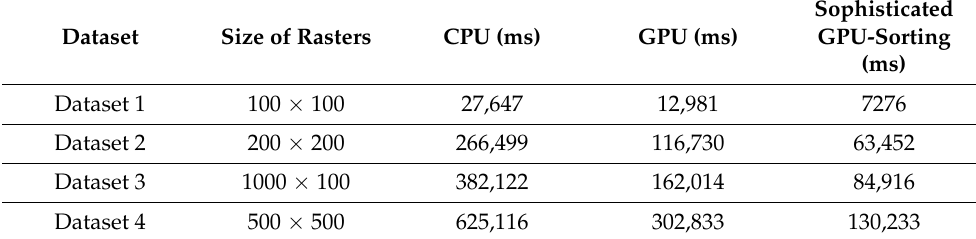
Table 6. Experiments on Watermark